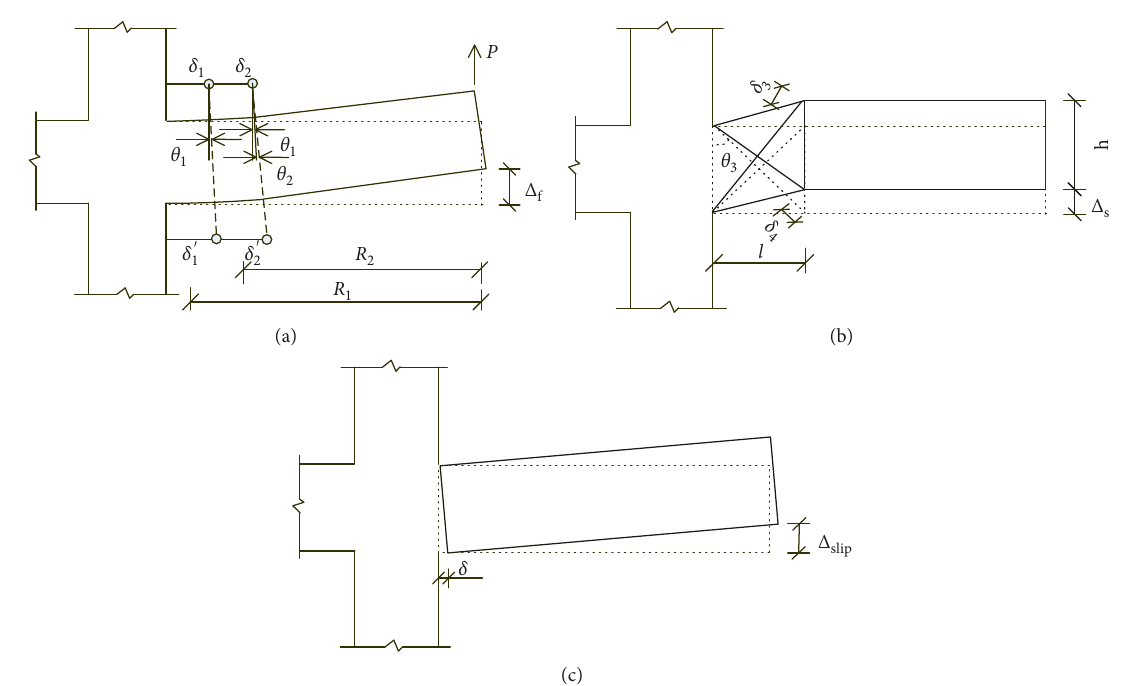
Figure 13: Three main deformation components: (a) bending, (b) shear, and (c)